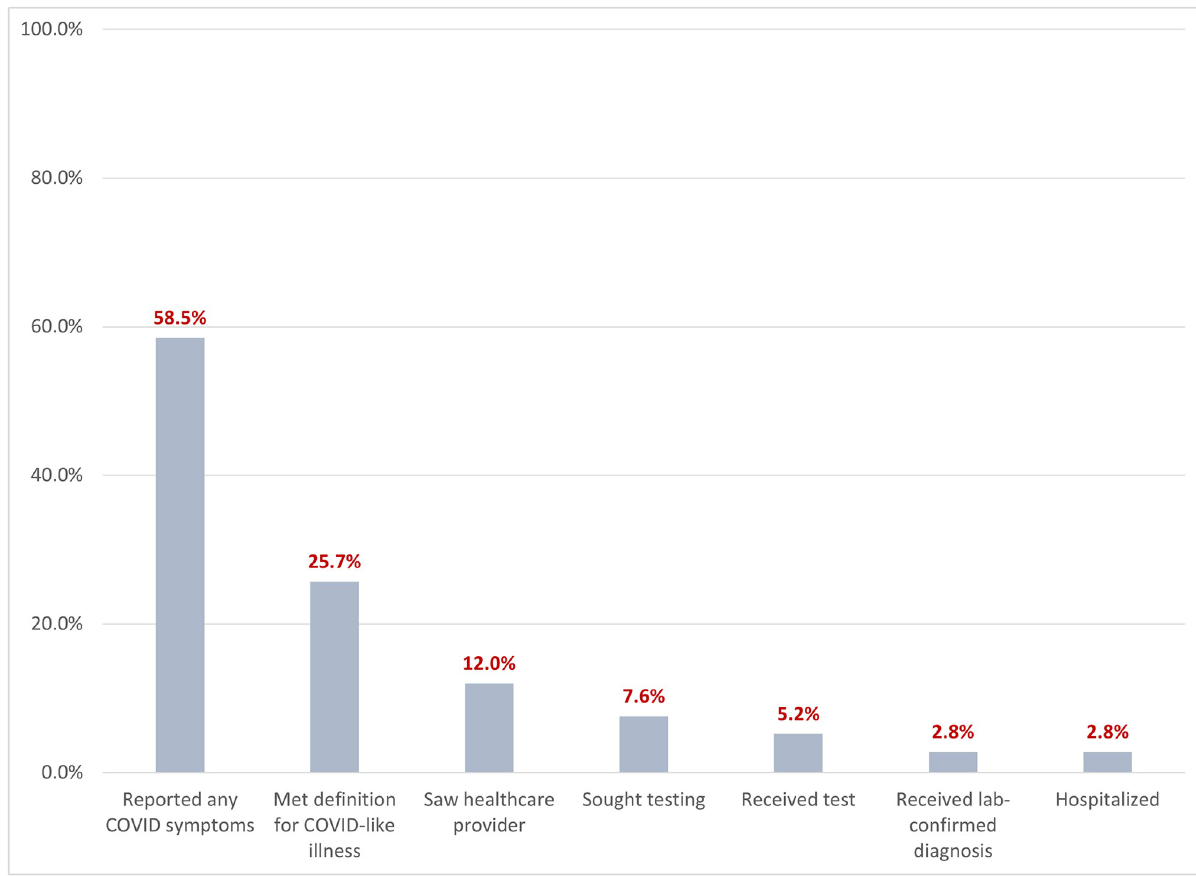
Fig 1. SARS-CoV-2 symptoms among persons screened for enrollment in the CHASING COVID Cohort Study, April 2020.